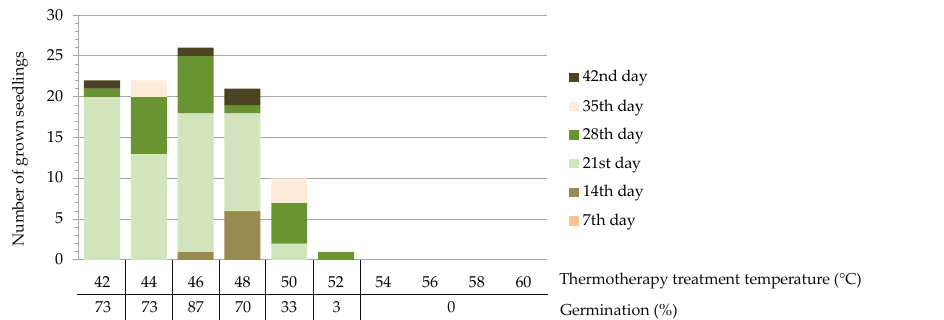
Figure 3. Germination success of Quercus robur acorns treated by thermotherapy for 2.5 h at differ- ent temperatures.